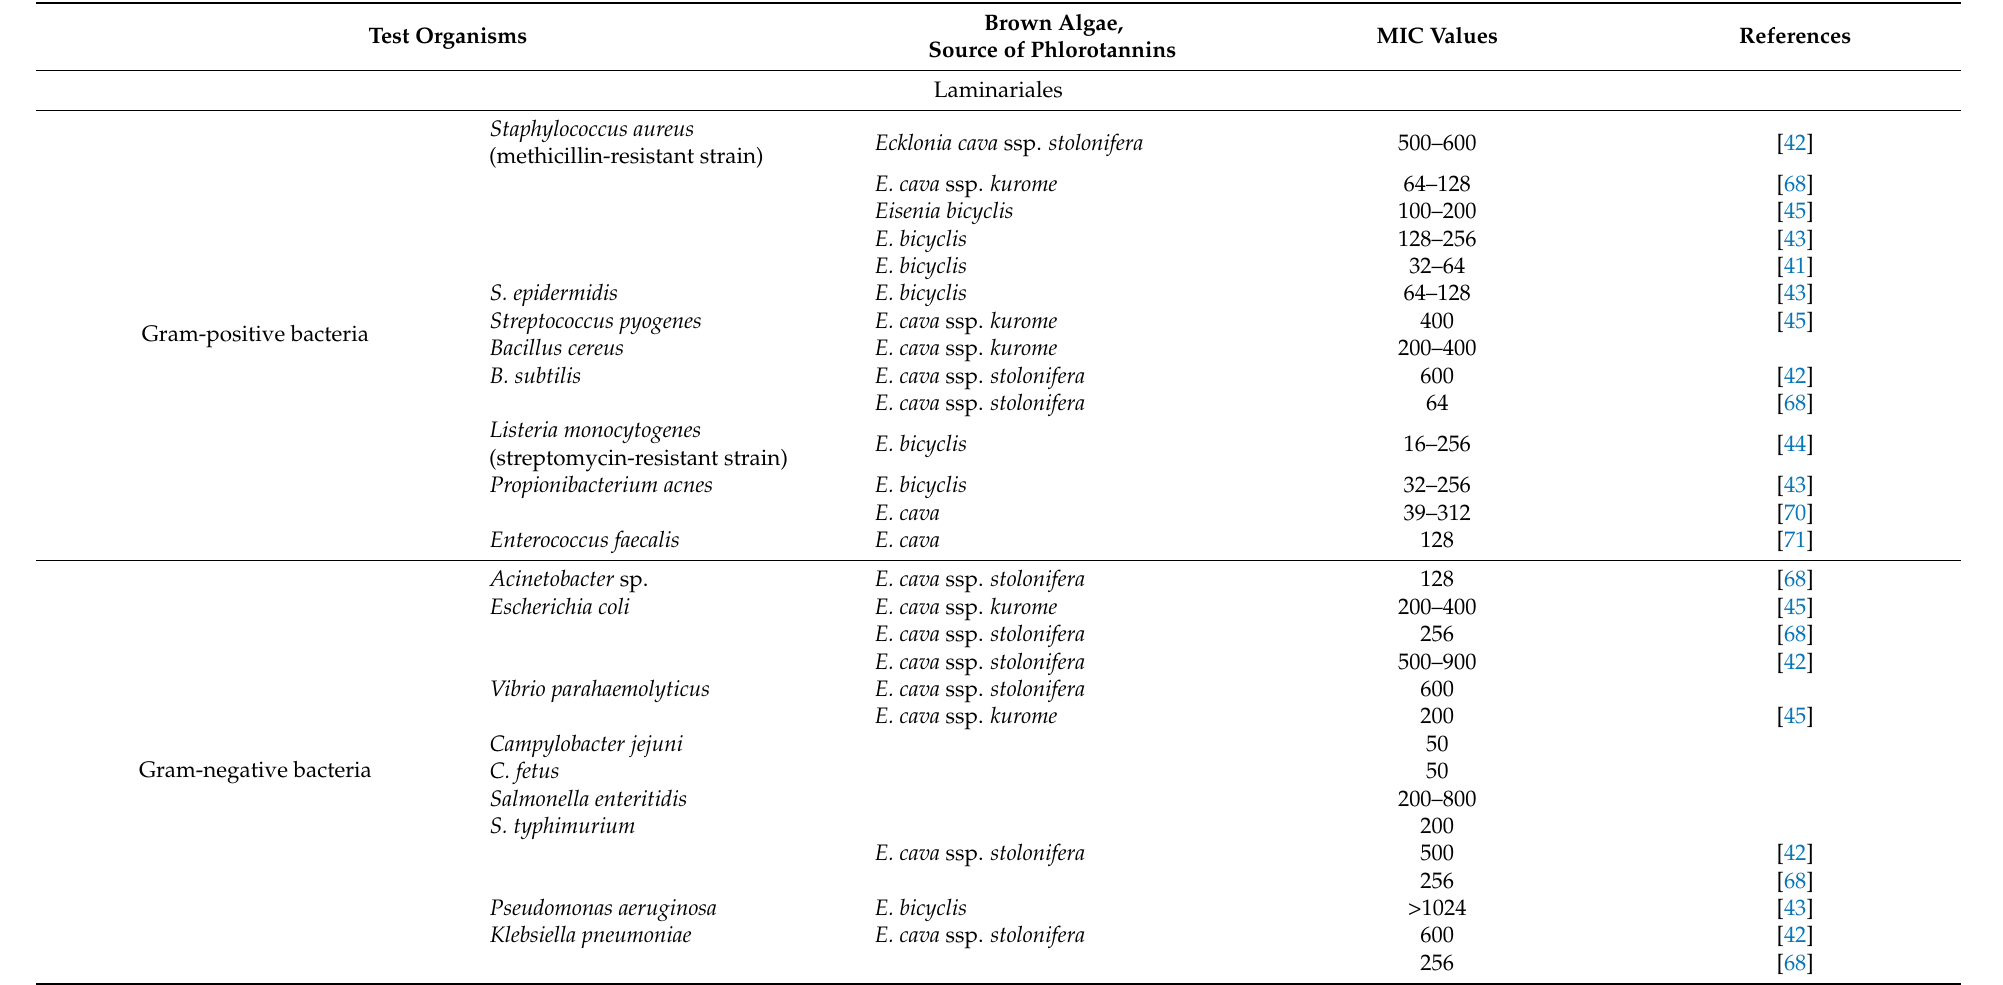
Table 2. Minimum inhibitory concentration (MIC, µ g/mL) of different phlorotannin preparations against bacteria, fungi, and microalgae according to available literature data. Algal species are named according to the current AlgaeBase classification